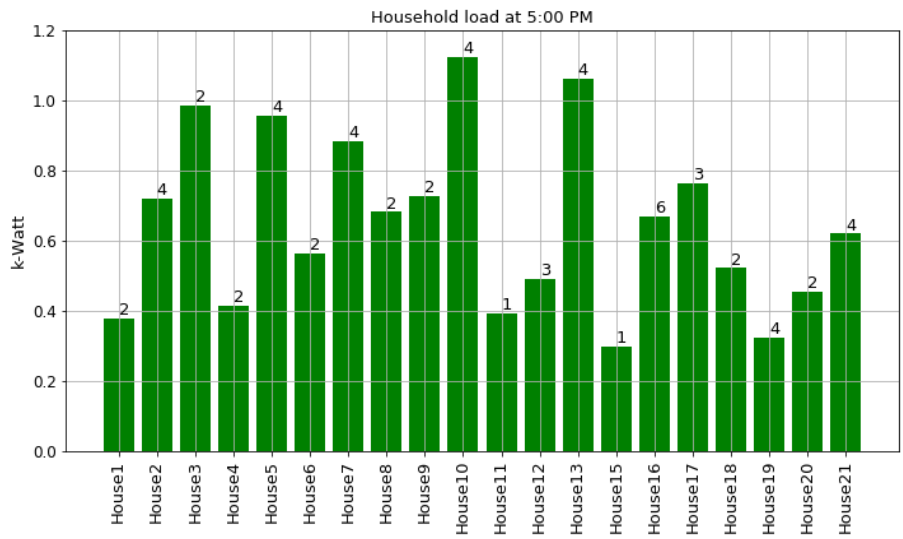
Figure A1. Household load at 5:00 PM. The numbers at the top of bars are the household occupancy.